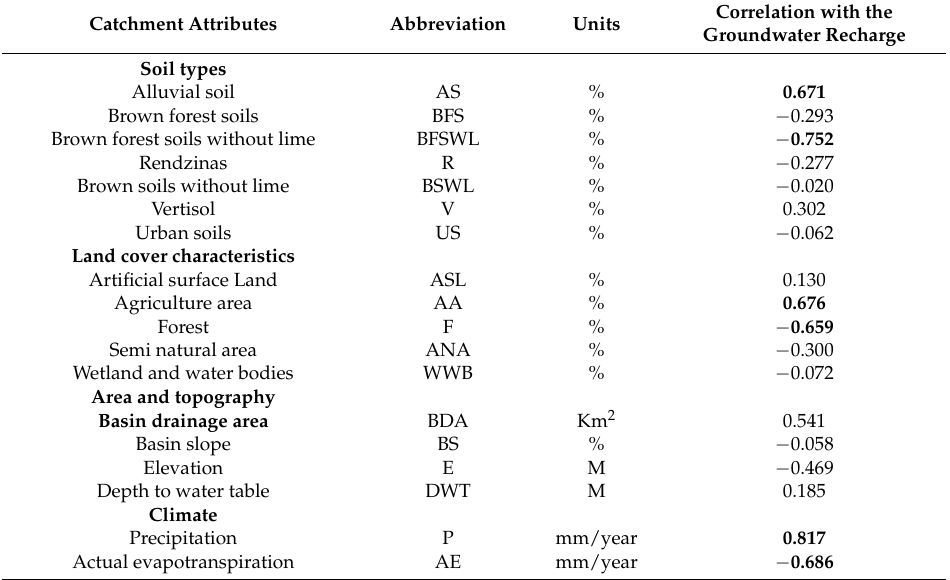
Table 4. Catchment attributes, units, and their Pearson correlation with groundwater